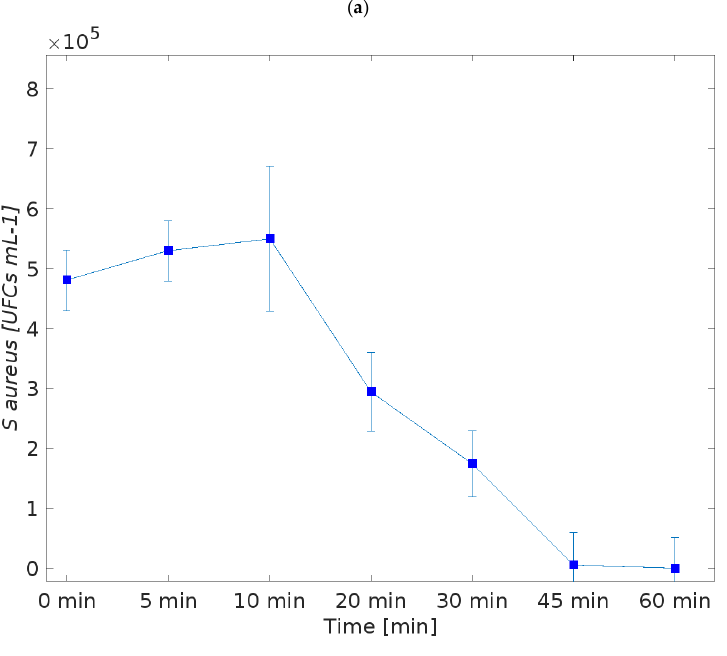
Figure 3. Killing-time curves of ( a , b ), the sample functionalized with HKUST-1 against S . aureus and E. coli bacteria, for up to 60 min of culture. Data derived from two repetitions (means S.D.) according to standards. Positive controls for each bacterium (growth without agent) were also conducted, reaching maximum values of 4.23 × 10 5 and 2.1 × 10 5 CFUs mL −1 for S. aureus bacteria agent-free solution and values of 0.98 × 10 6 and 1.24 × 10 6 CFUs mL −1 for E. coli bacteria agent-free solution, after 1 h (data not shown in